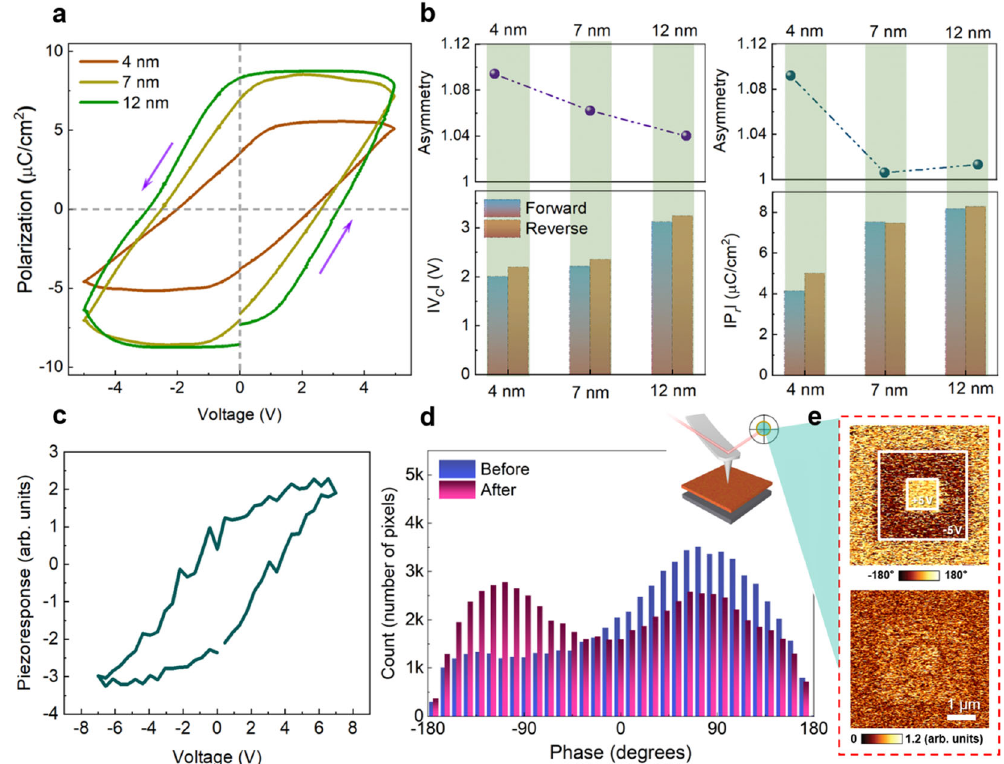
Fig. 4 Ferroelectricity of PLD-grown HZO on Si. Dependency of ( a ) P – V (at 10 kHz) curves ( b ) magnitudes of |V c |, |P r | and curve-asymmetricity on the thickness of HZO (4 nm, 7 nm, and 12 nm) ( c ) PFM hysteresis loop averaged from 25 measurements ( d ) Histograms of PFM phase, before and after poling, over the same area ( e ) PFM of HZO thin fi lms after poling with applied tip voltages of ±5